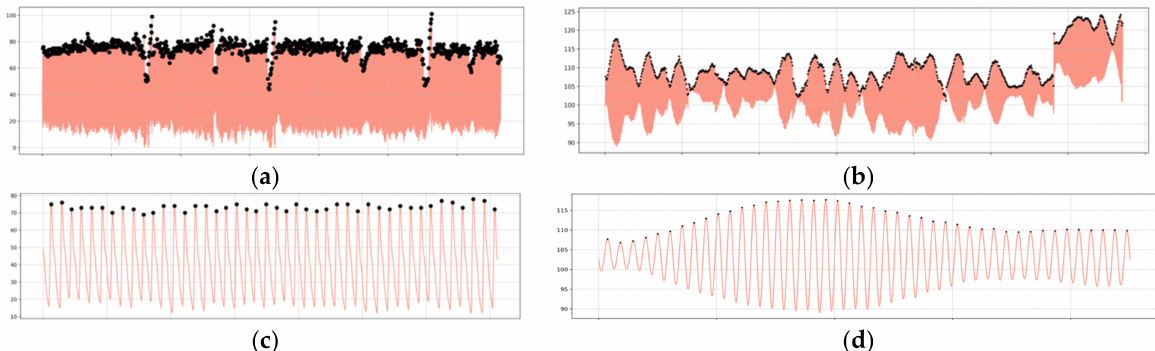
Figure 4. ( a ) Raw PPG signal with peak detection; ( b ) color-augmented video with peak detection; ( c ) half-minute interval of the raw PPG signal with peak detection; ( d ) half-minute interval of the color-augmented video with peak detection.